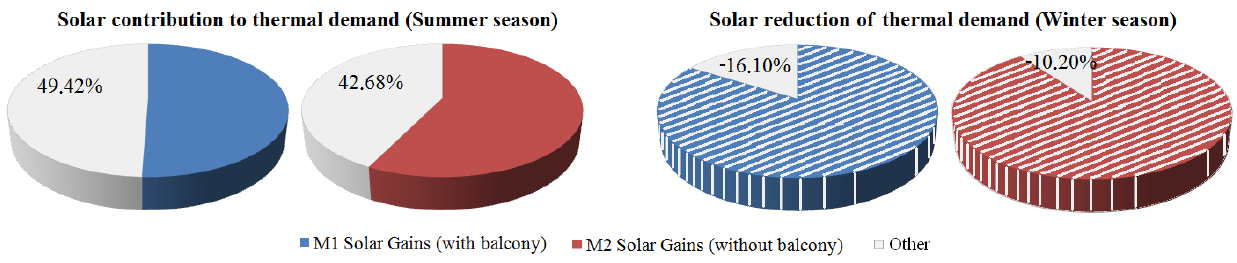
Figure 6. Annual contribution of solar gains in the original dwelling unit (south-facing).